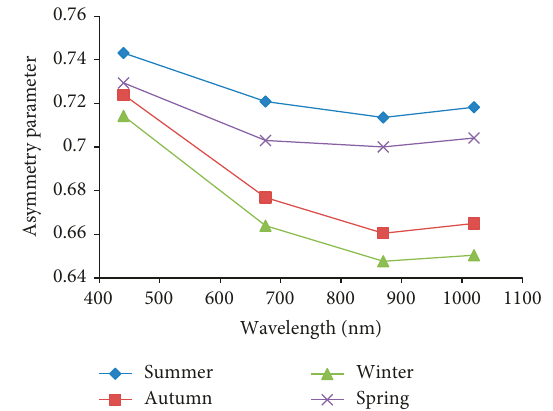
Figure 9: Variations in the seasonal averaged asymmetry